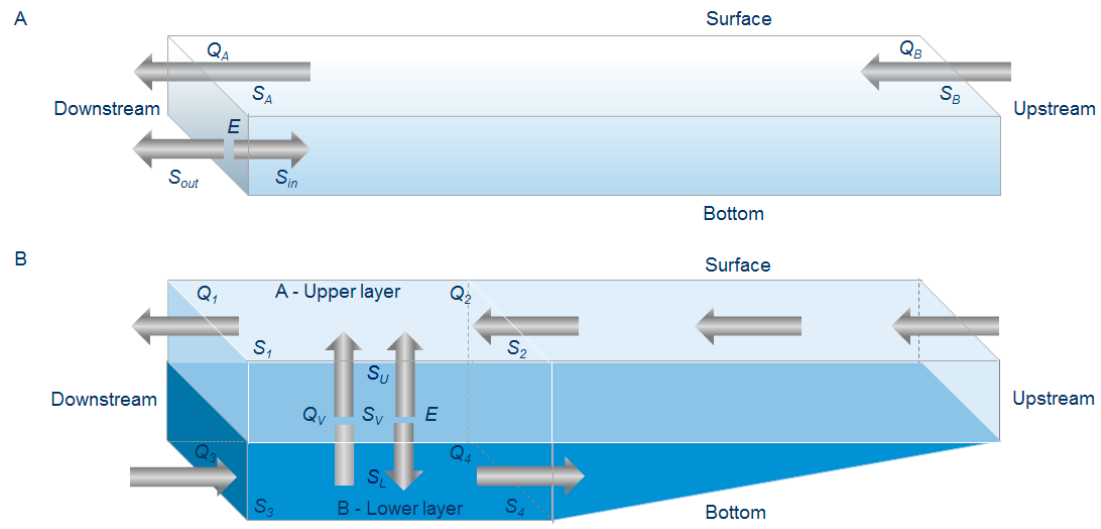
Figure 2. Layout of the box model used in this study: fluxes and exchange coefficients for the one layer box model ( A ), and two-layer box model ( B ). Q x represents the flow rate (m 3 s − 1 ) of the water with salinity S x . E v represents the non-advective vertical exchange coefficient between the two layers. S U , S L and S V represents mean salinities. E corresponds to the non-advective exchange coefficient.